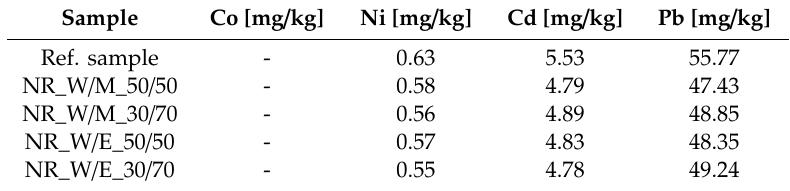
Table 5. Concentrations of metals (II) in samples of dry solid residues after lyophilization process.